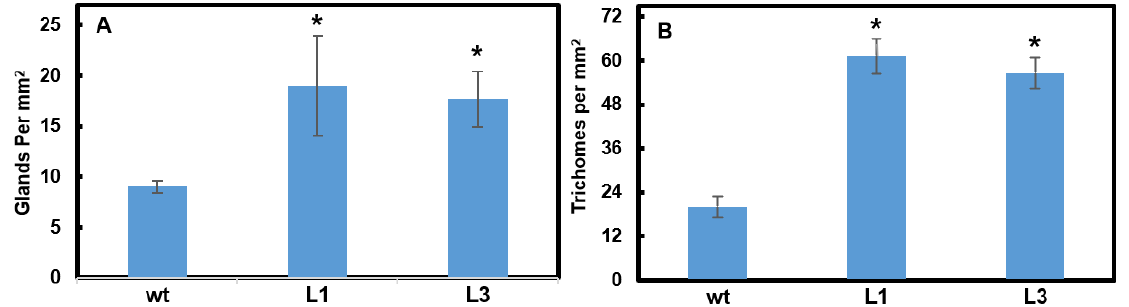
Figure 5. Tobacco transgenic lines overexpressing CsMIXTA generated more trichomes than wt. ( A ) Average number of glands on the glandular trichomes per mm 2 , observed by intrinsic fluorescence as shown in Figure 4G–I. ( B ) Average trichome number per mm 2 , obtained from SEM images in Figure 4A–C. Averages taken from 3 biological reps ( n = 3) for each transgenic line and wt. * indicates p < 0.05, which was determined using Student t-test by comparing the two transgenic lines to wt.